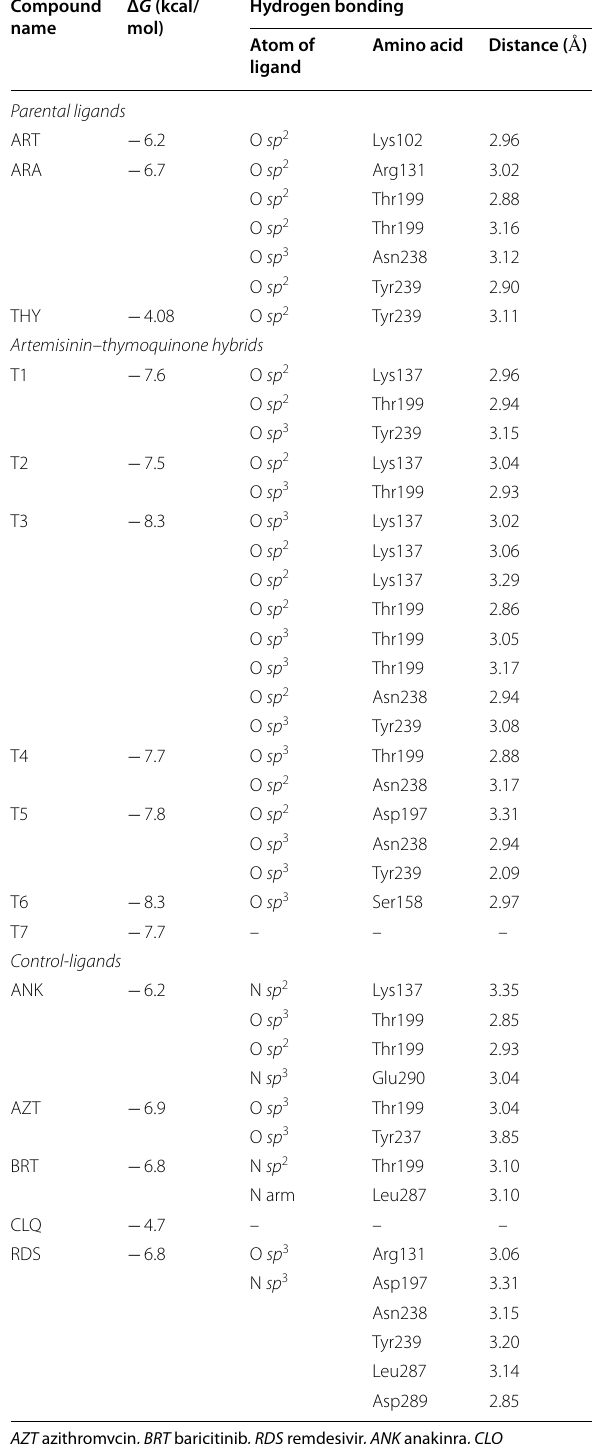
Table 1 Interactions, distances and energy parameters of ligands in molecular docking with Mpro